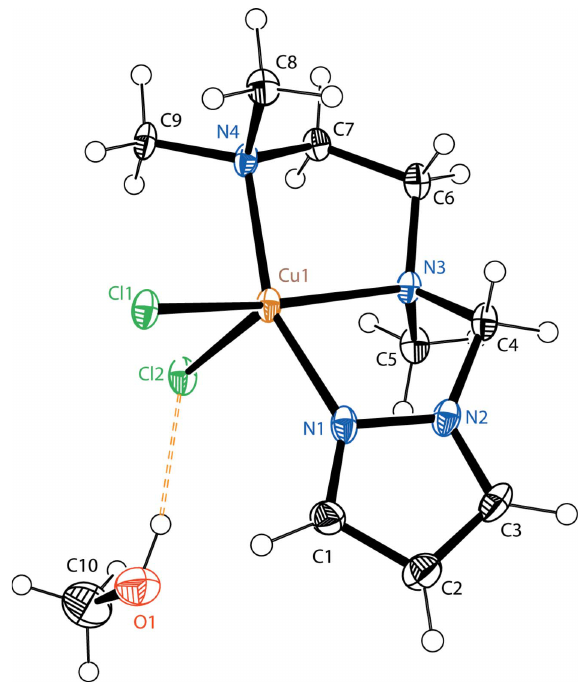
Figure 1 The asymmetric unit of the title compound, with displacement ellipsoids drawn at the 40% probability level. The intermolecular O—H (cid:2)(cid:2)(cid:2) Cl hydrogen bond between the solvent molecule and the main complex is also